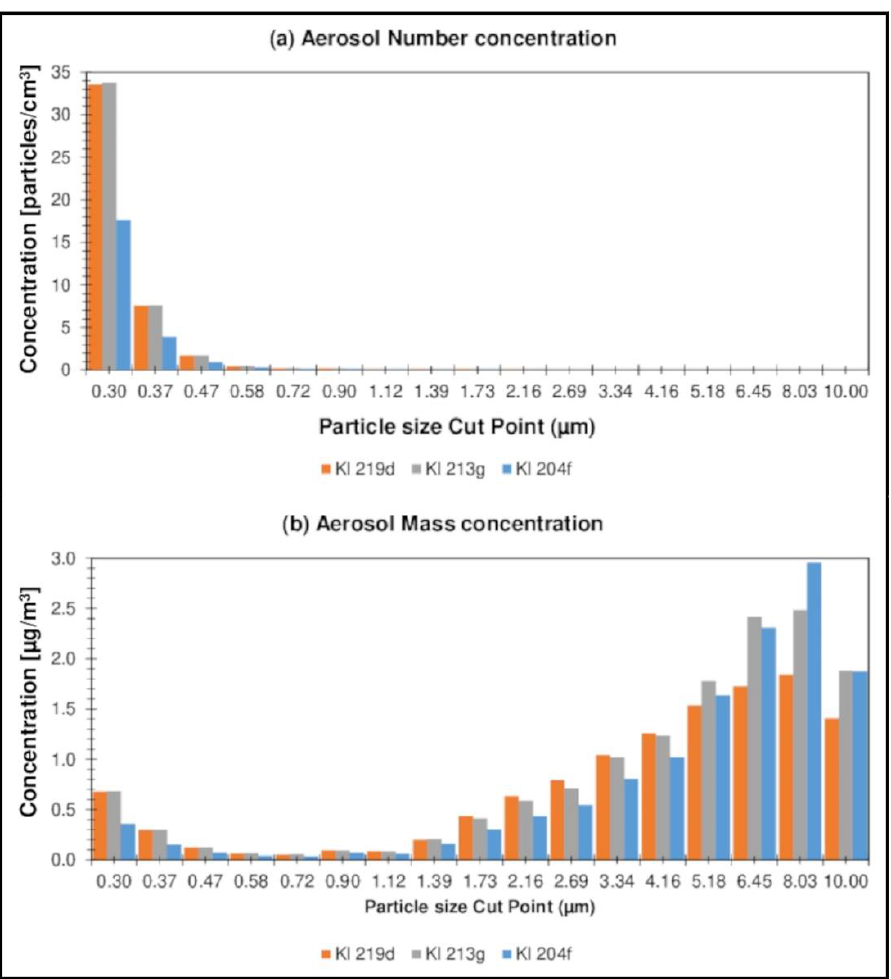
Figure 8. Aerosol number ( a ) and mass concentrations ( b ), taking into account the distribution of Figure 8. Taking into account the distribution of aerosol particle diameters, for Central European aerosol particle diameters, for Central European submountainous beech forests. submountainous beech